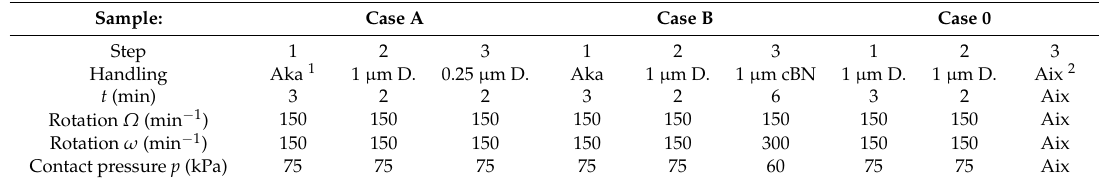
Table 2. Machining protocol for surface topology